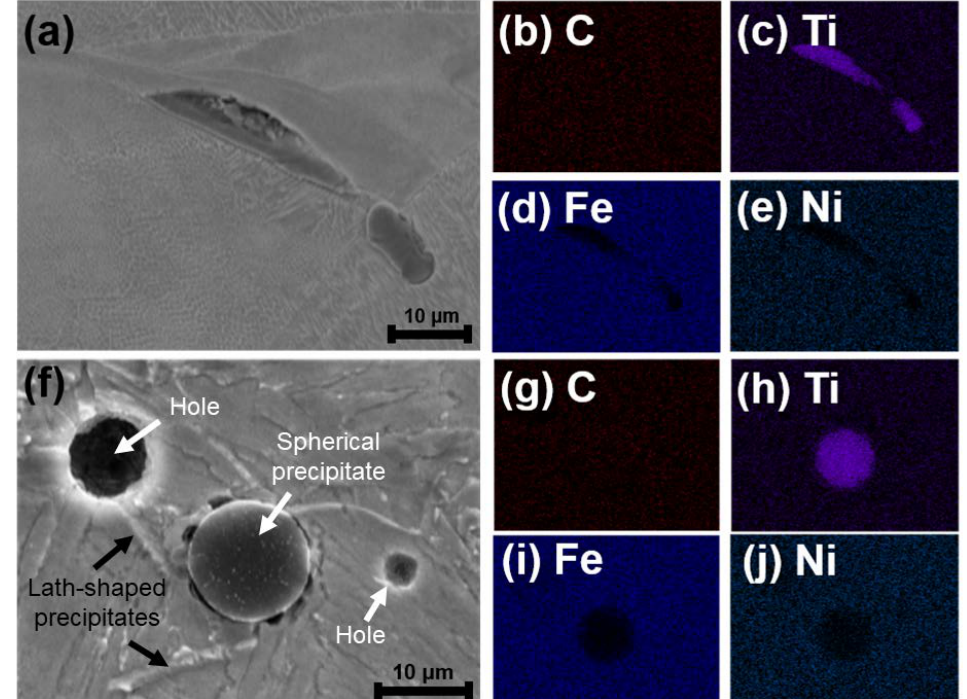
Figure 7. ( a ) SEM image and ( b – e ) energy dispersive X-ray mappings of coarse precipitate formed along melt pool boundary in as-built condition; ( f ) SEM image and ( g – j ) energy dispersive X-ray mappings of spherical precipitate inside bead after 850 °C ST for 2 h and aging at 500 °C for 6 h.